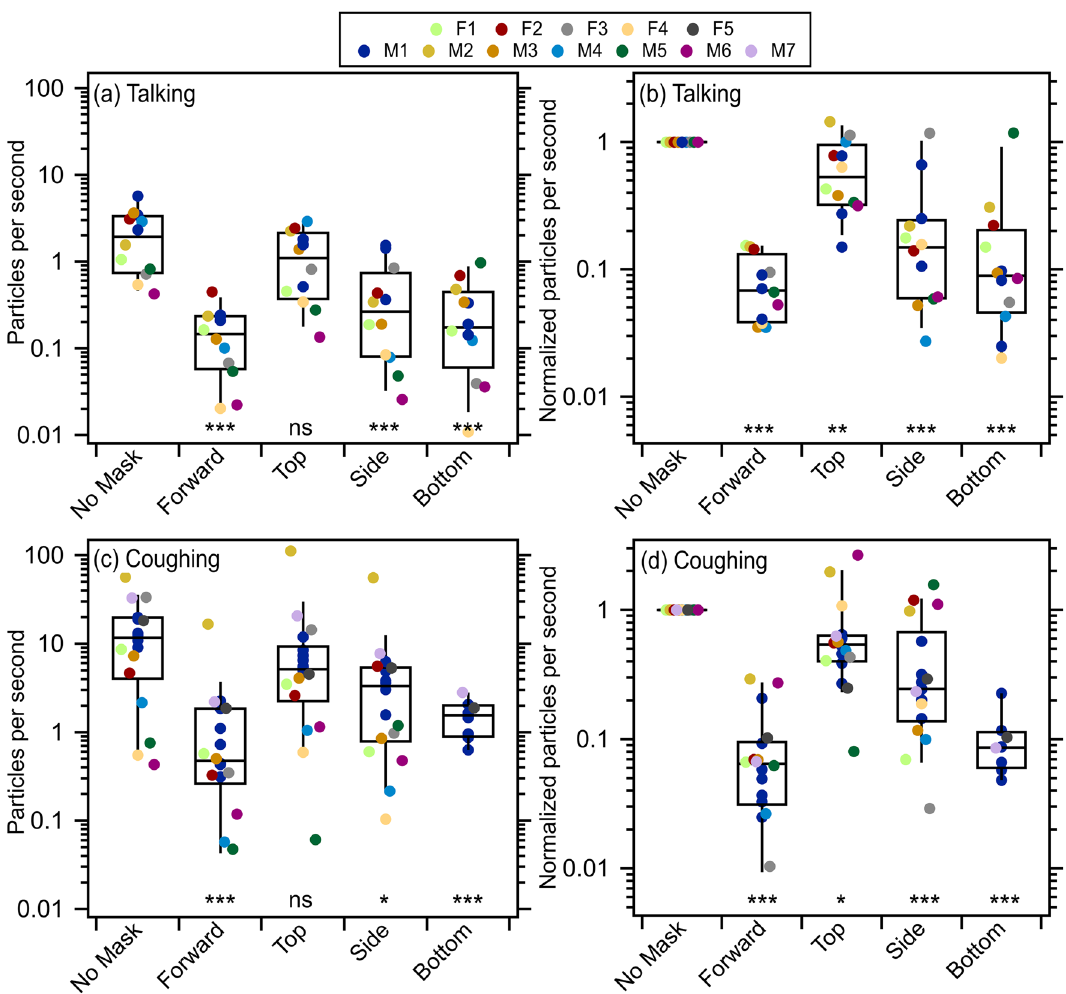
Figure 2. Measured particle count rates, uncorrected for flow, associated with ( a ) talking and ( c ) coughing when participants were positioned in one of the four orientations (forward, top, side, bottom) when masked and with no mask in the forward direction. Measured particle count rates normalized to the no mask case for each person for ( b ) talking and ( d ) coughing. The statistical significance of the difference from no mask is indicated, with ns ( p > 0.05), * ( p ≤ 0.05), ** ( p ≤ 0.01), and *** ( p ≤